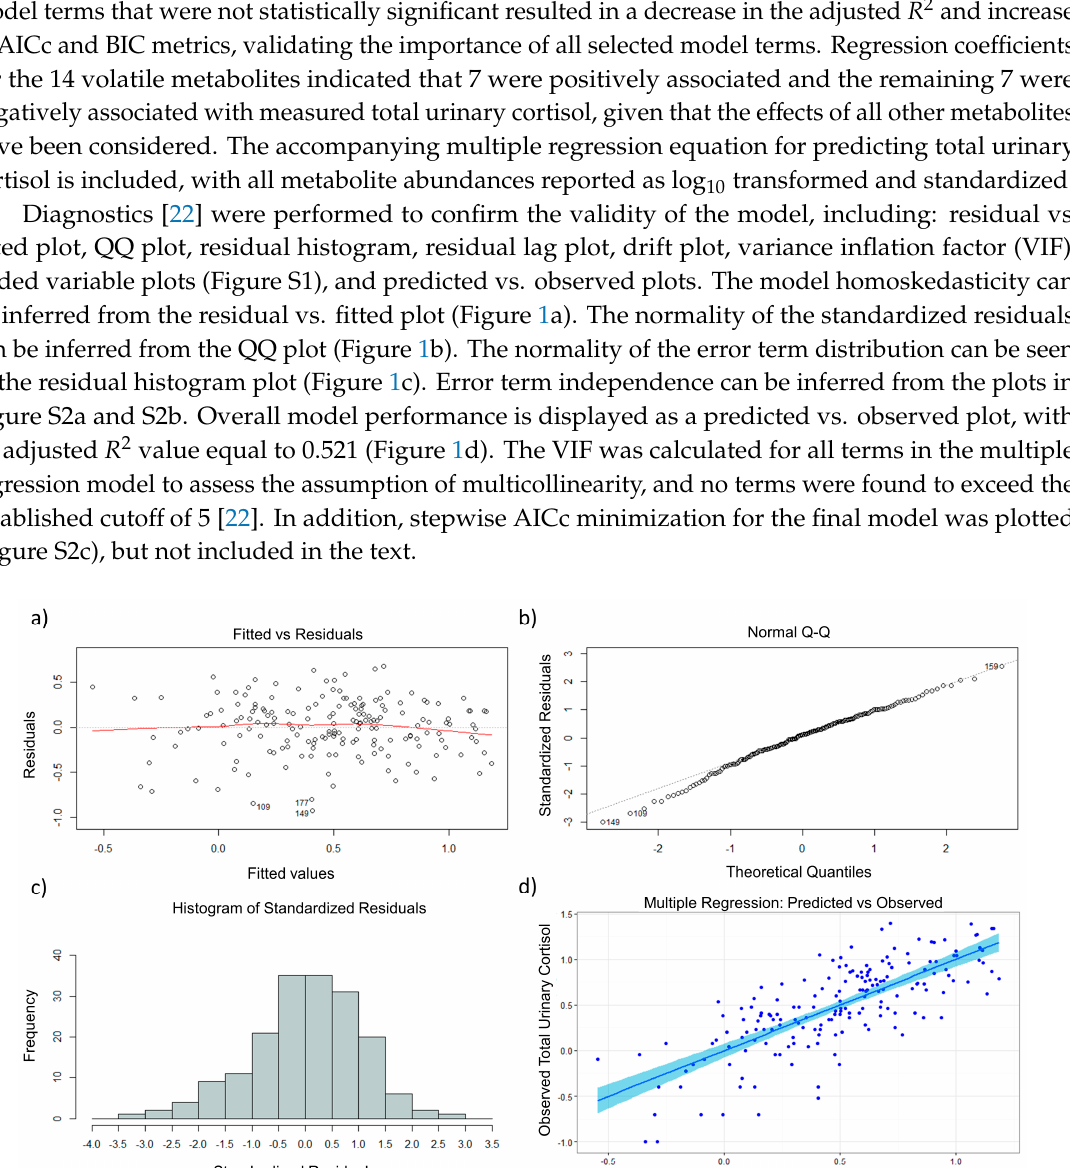
Table 2. Interaction terms used in the model have the following information provided: compound name, dummy variable, regression coefficient, confidence interval, and F-statistic corrected p-value.